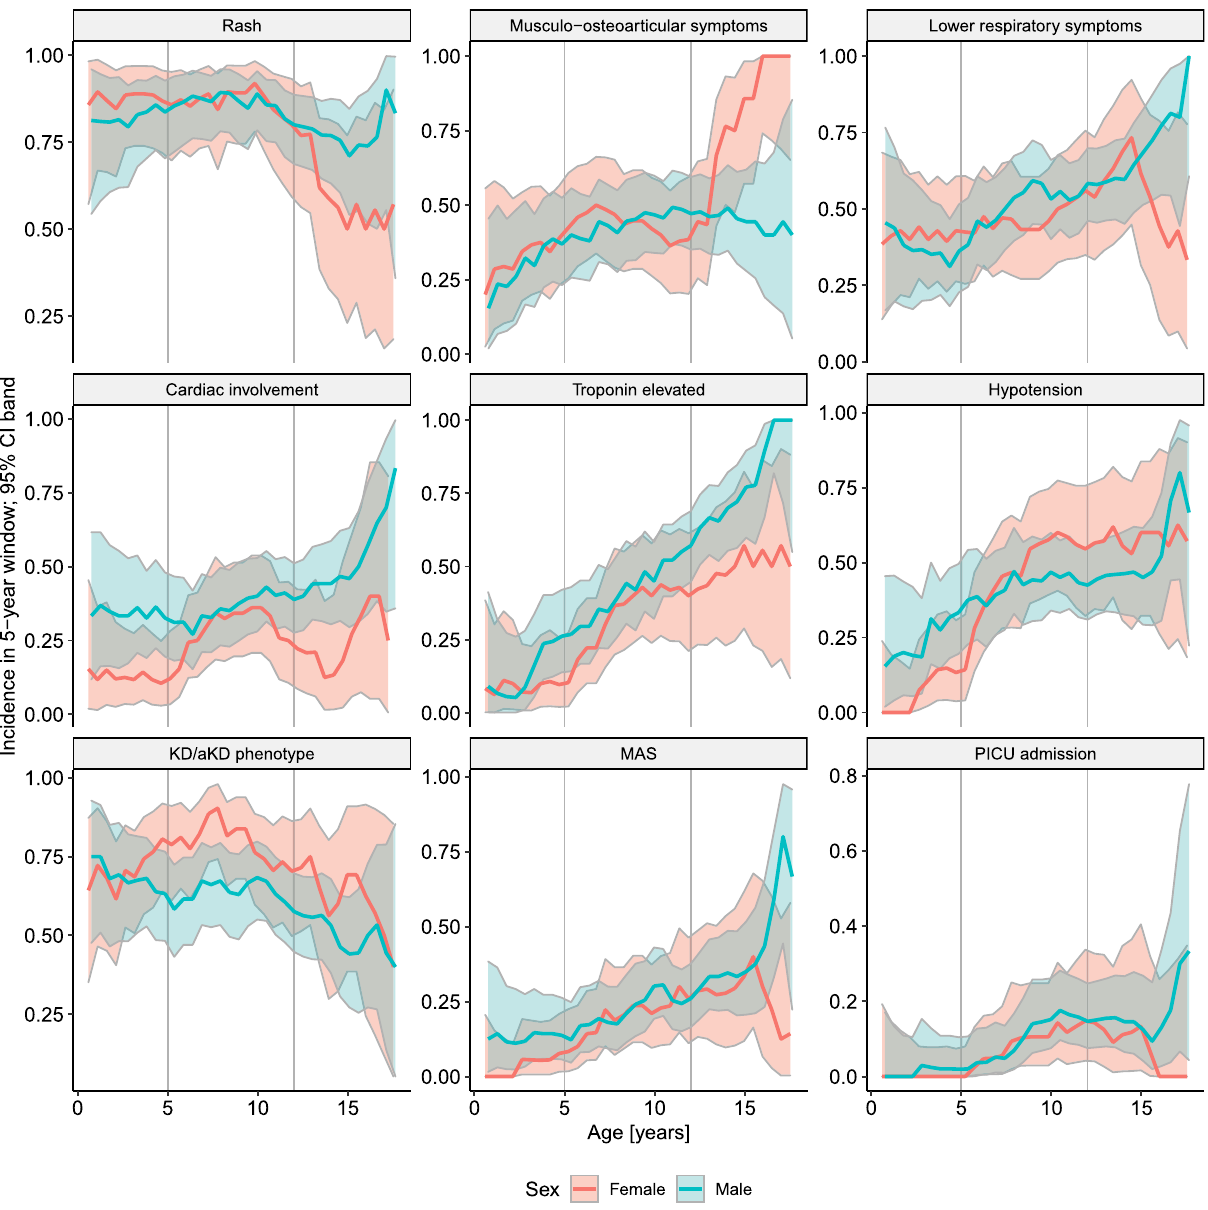
Figure 3. Incidence of the selected events within the study group, according to age and sex. KD/aKD, Kawasaki disease/atypical Kawasaki disease; MAS, macrophage activation syndrome. Musculo-osteoarticular symptoms encompassed: muscle pain, arthralgia, or arthritis. Lower respiratory symptoms encompassed: chest pain, cough, or dyspnea. Cardiac involvement encompassed left ventricular ejection fraction < 55%, or coronary artery abnormalities (dilation or aneurysm), or pericardial